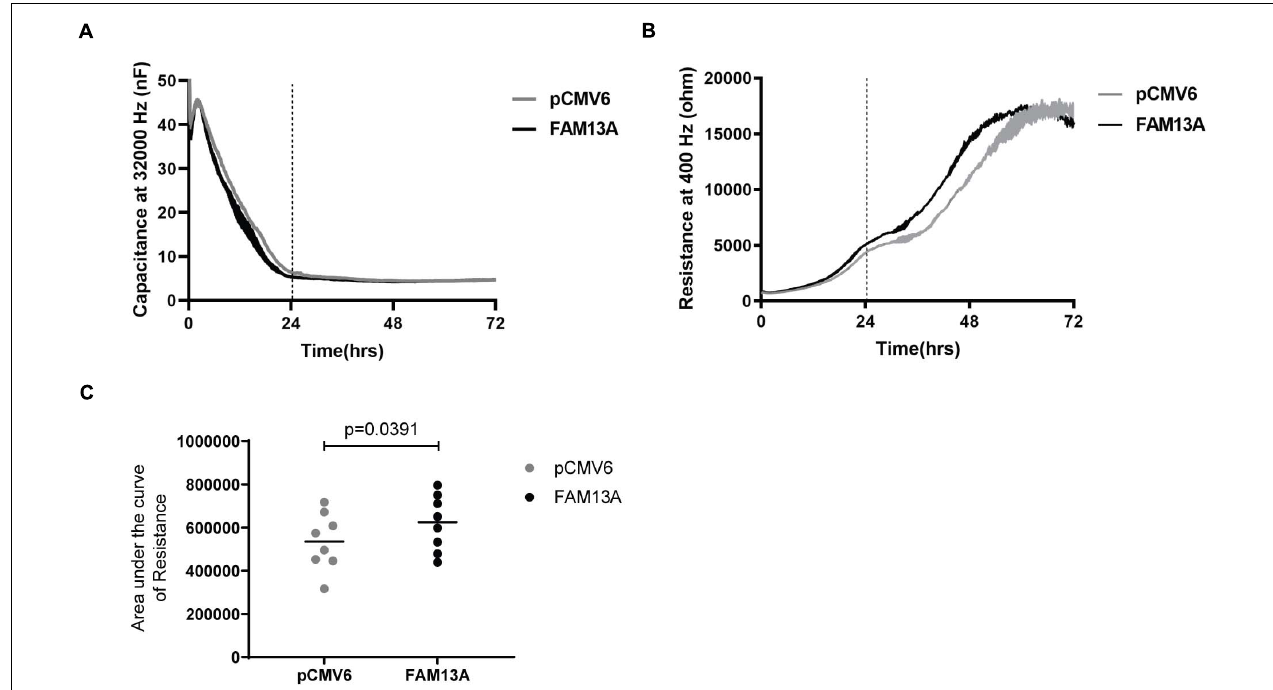
FIGURE 4 | Significantly more rapid building-up of electrical resistance upon FAM13A overexpression in 16HBE14o- cells. 16HBE14o- cells were transfected with FAM13A overexpression plasmid or empty vector (pCMV6). After 24 h, the cells were trypsinized and seeded in duplicates into ECIS arrays. The high-frequency capacitance and low-frequency resistance were monitored over 72 h after seeding. (A) High-frequency capacitance and (B) low-frequency resistance values of a representative ECIS experiment. The vertical line indicates the time when cells reached confluence as indicated by the stabilization of high-frequency capacitance. Data are shown as mean ± SEM of two duplicates in the ECIS array. (C) The area under the curve (AUC) of resistance values from 0 to 72 h was calculated and depicted as mean and individual experiments ( n = 8). Significant differences were assessed by the Wilcoxon signed rank test and p -value is